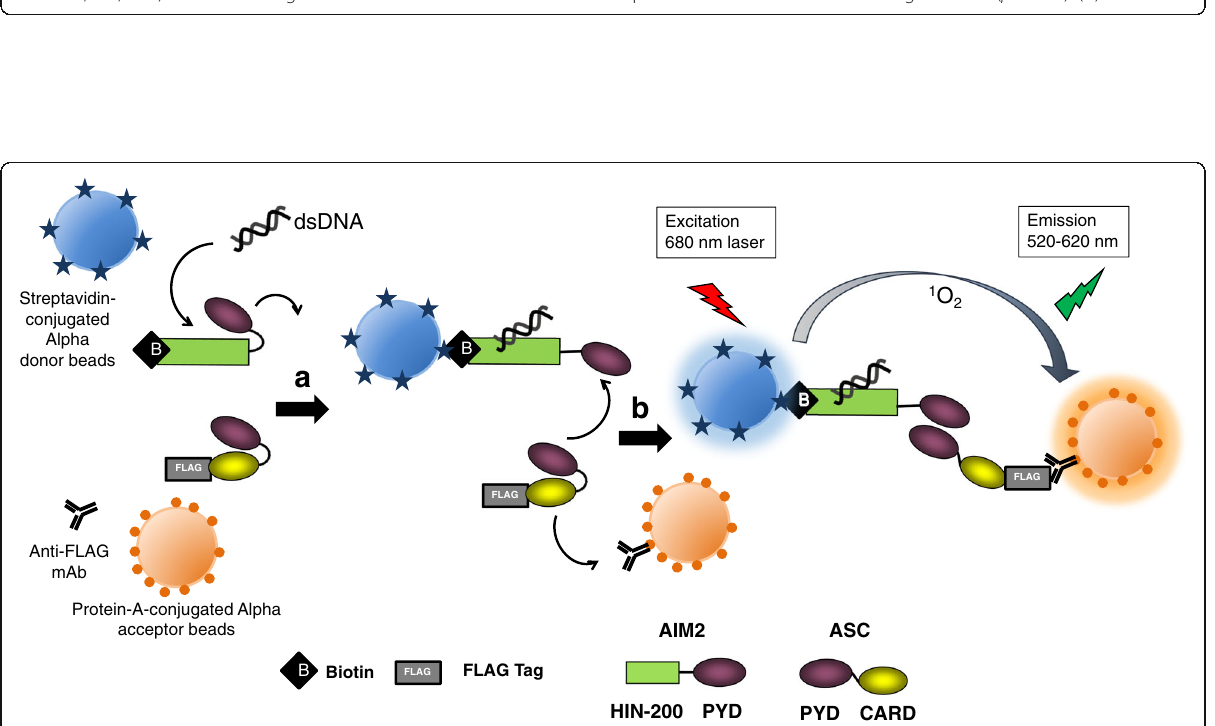
Fig. 3 A possible mechanism of AIM2 inflammasome in a cell-free system. The PYD domain of AIM2 interacts with the HIN-200 domain of AIM2 loosely upon being incubated with no materials. Once a specific ligand poly(dA:dT) stringently interacts with the HIN-200 domain of AIM2 and streptavidin-conjugated donor beads, then the PYD domain of AIM2 apart from the HIN-200 domain of AIM2 opens to interact with the PYD domain of ASC ( a ). Since the PYD domain of ASC loosely interacts with the CARD domain of ASC, the interaction between the PYD domain of AIM2 and PYD domain of ASC is thought to open the CARD domain of ASC, which will lead to interaction with protein A-conjugated acceptor beads ( b